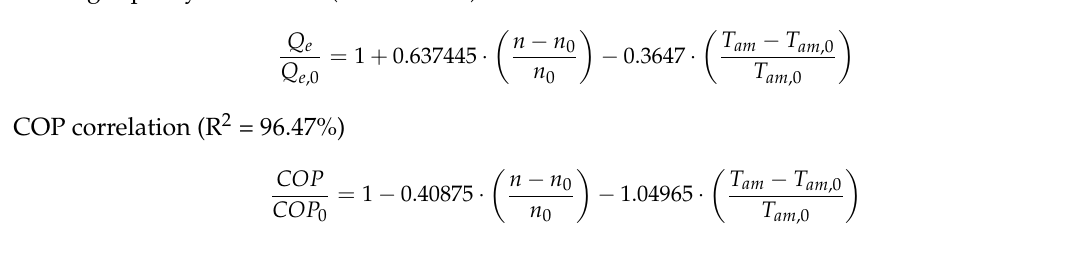
Figure 17. Rotational speed for different ambient temperatures and COP ( T ind = 25 °C and 1000 rpm < n < 4000 rpm).